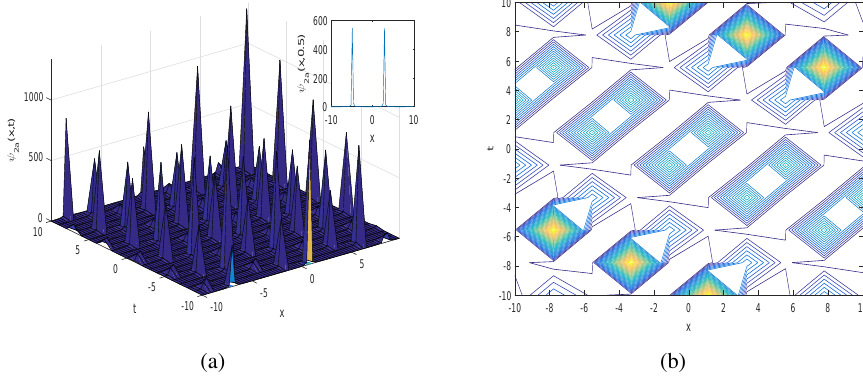
Fig. 1 The (a) 2D, 3D and (b) contour surfaces of Eq.